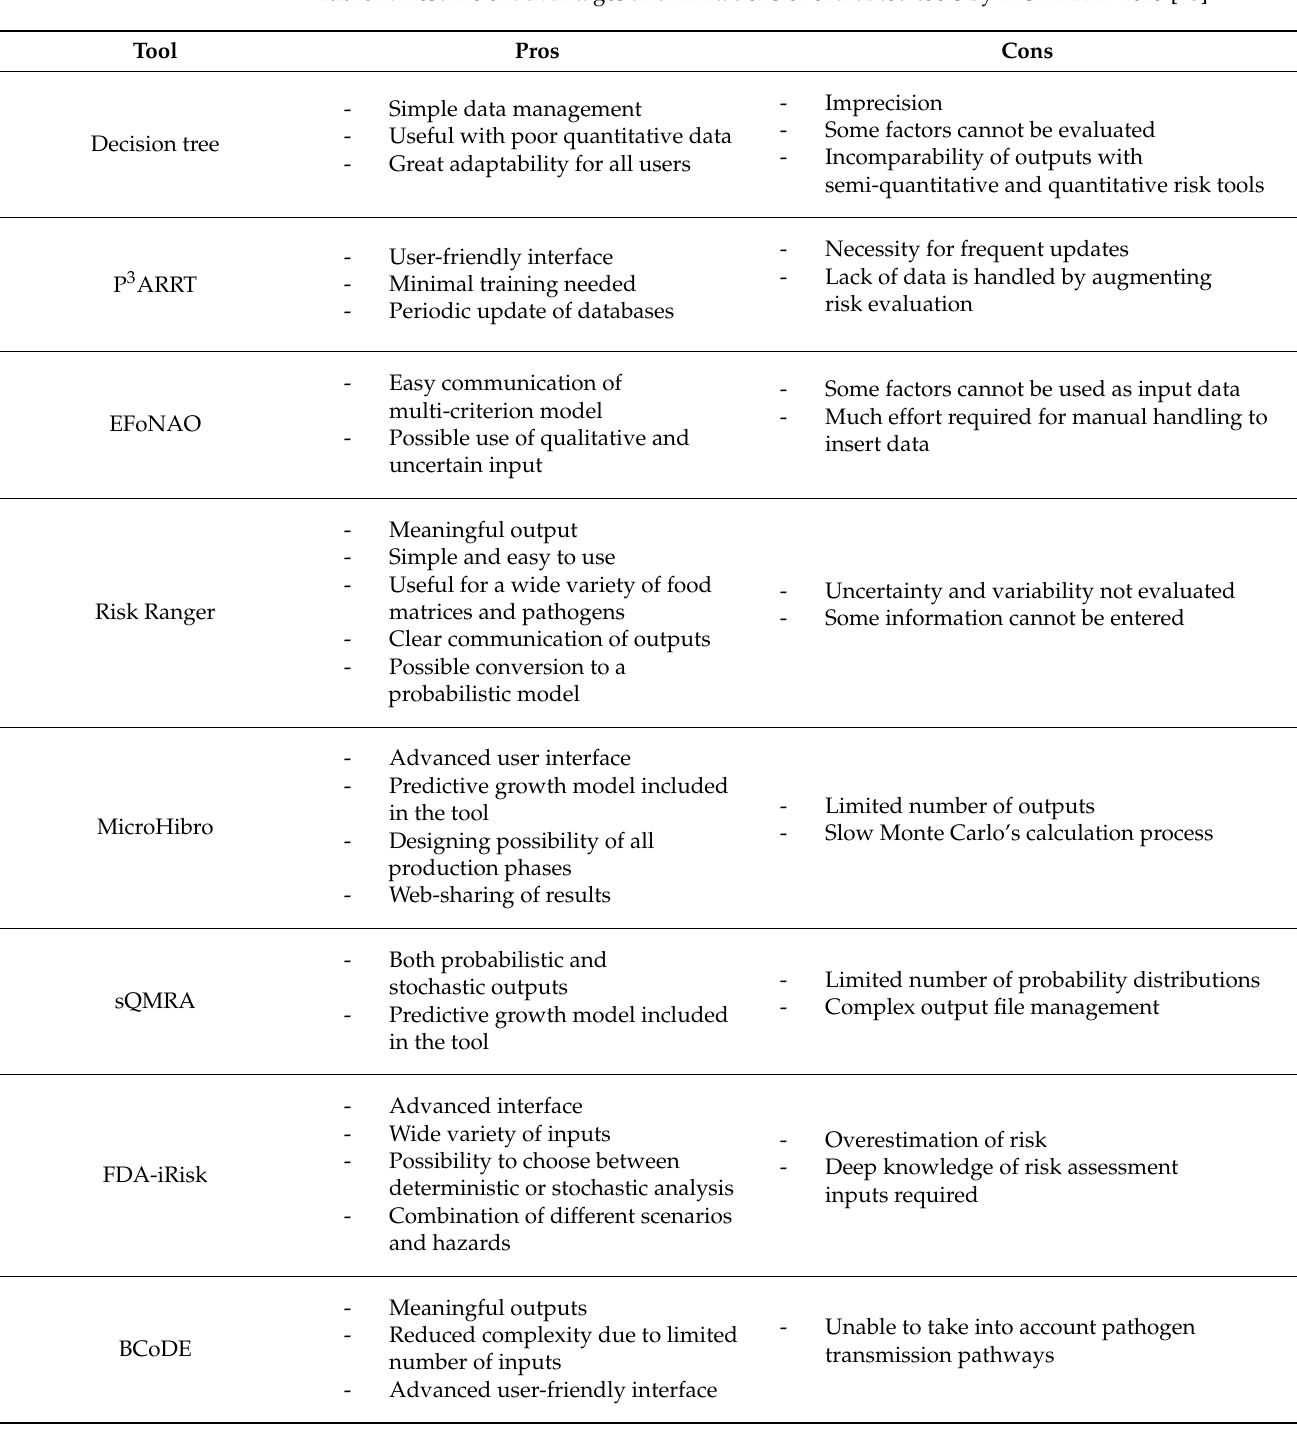
Table 4. Resum é of advantages and limitations of evaluated tools by BIOHAZ in 2015